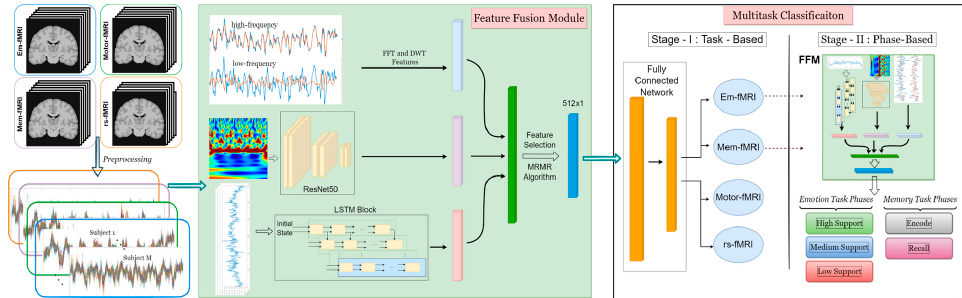
Figure 1. The proposed framework for automatic multitask classification of functional data. Raw functional images are acquired from cognitive (based on a memory task (mem-fMRI)), behavioral (based on a motor task (motor-fMRI)), and affective (based on an emotion task (em-fMRI)) fMRI tasks and a resting-state fMRI scan. All BOLD signals for N subjects (differs according to the dataset) are processed with the standard preprocessing steps with SPM. In FFM, the feature generation procedure is as follows: (i) each signal is decomposed into its low-frequency and high-frequency components with DWT and FFT; (ii) BOLD signals are converted into an image and fed into a ResNet-50; (iii) an LSTM block is employed to the BOLD signals. Once the three-step procedure is completed, all features are combined, and the most relevant features among them are selected with the MRMR algorithm. Finally, the obtained feature vector is fed into the Fully Connected Network (FCN) to conduct the task-based multitask classification (Stage I). For the sub-phase classification (Stage II), the FFM should be run again before the